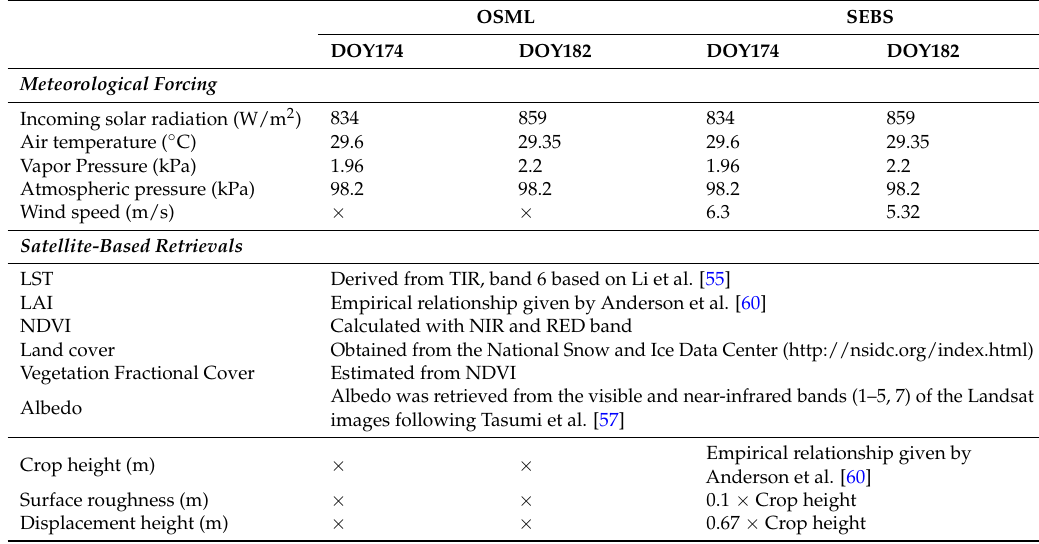
Table 1. Meteorological forcing and satellite-based observations required for OSML and SEBS for SMACEX site.